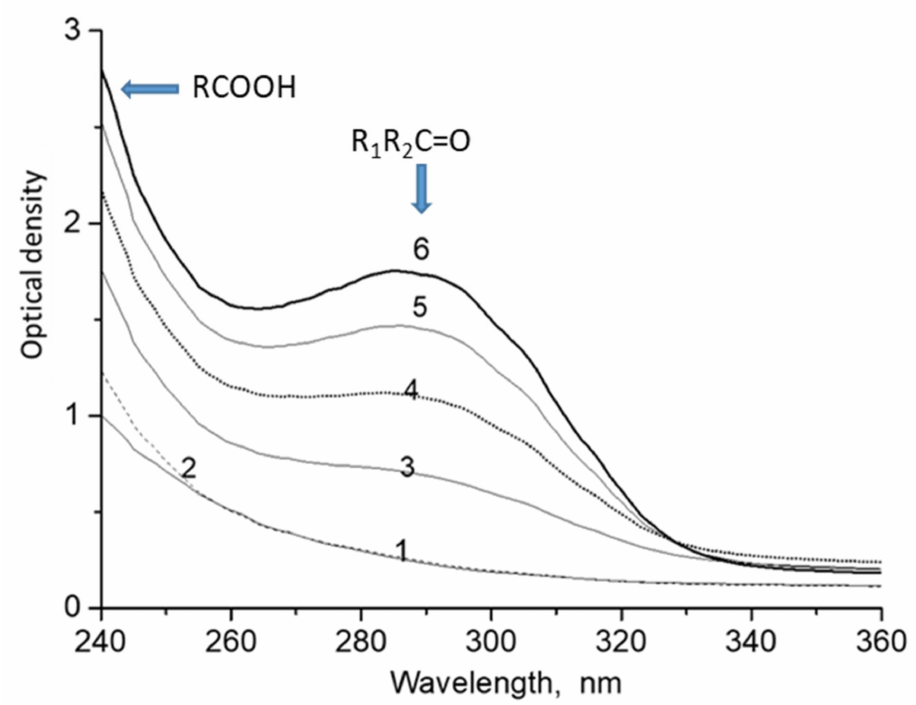
Figure 1. UV-spectra of decalin after ozonation. The optical path, 1 cm. [O 3 ] = 100 mg/L. The flow rate of the ozone-oxygen mixture was 2 mL/s. T = 20 ◦ C. Decalin ozonation time (min): 1—0; 2—2; 3—5; 4—10; 5—15 and